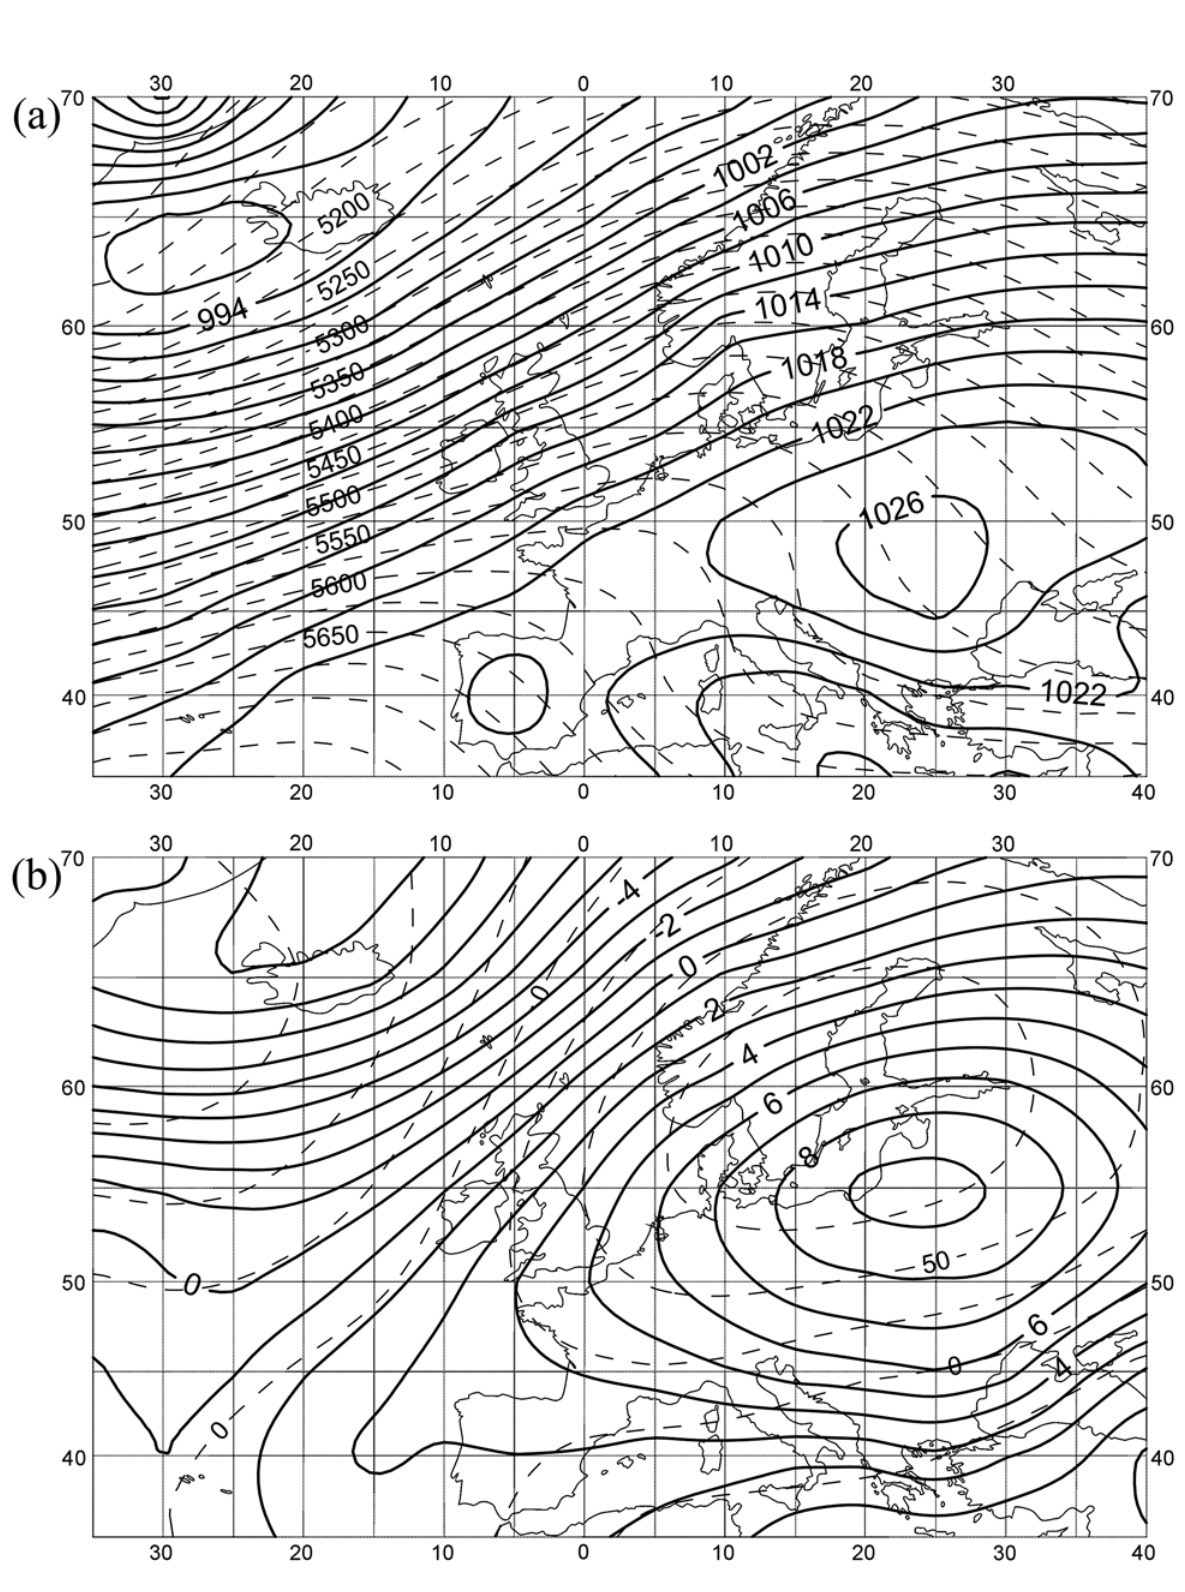
Fig. 8. Mean sLP (in hPa) and z500 hPa (in gpm) during the christmas period (a) and sLP (in hPa) and z500 hPa (in gpm) anomalies (b) in type